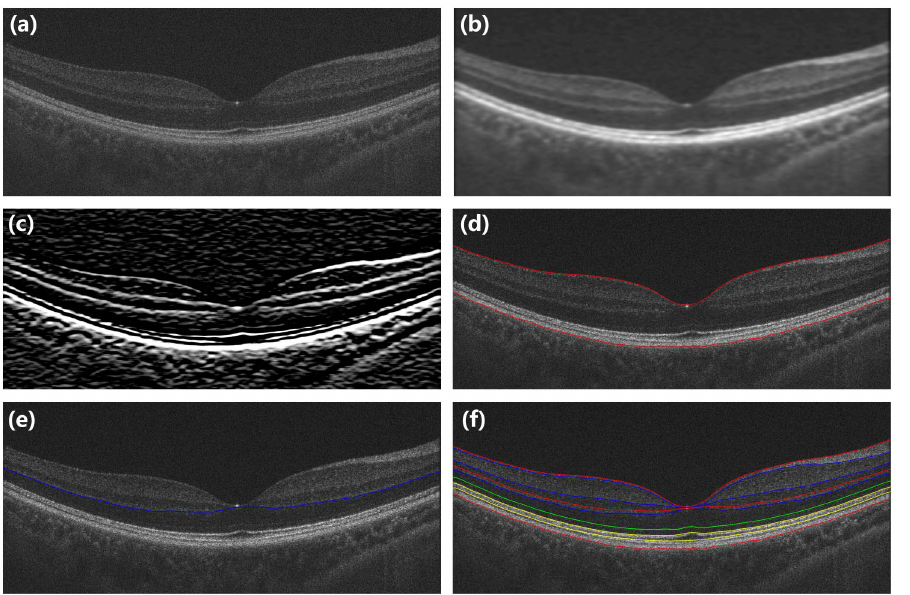
Figure 2. The detailed sequence in the boundary segmentation process. (a) Original image. (b) Image smoothing. (c) Gradient image. (d) The ILM and the boundary between the RPE and choroid layers were first segmented. (e) Limiting detection area and search the minimum-weighted path. (f) Segmented image.